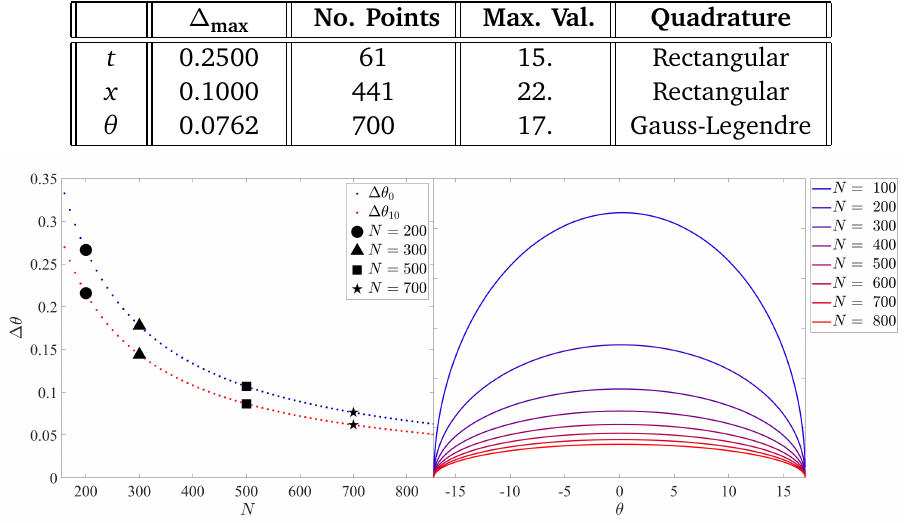
Table 3: Discretisation parameters and quadratures chosen for the two numerical simulations discussed in this paper (i.e. with and without a bath). From the left, the columns indicate (respectively for t , x , θ ): the variable, the lowest resolution (i.e. the largest spacing between two grid points ∆ ), the number of grid points, the max largest absolute value the variable takes, and the type of quadrature implemented. In the rectangular quadrature we have implemented equidistant grid points with fixed spacing ∆ . max